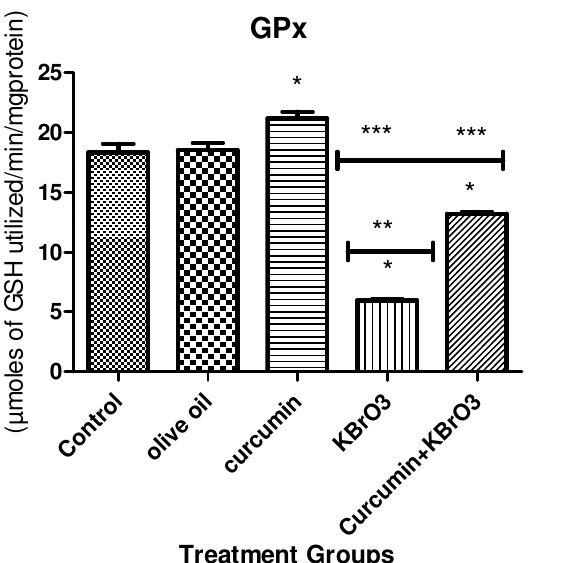
Fig. 6. Effect of curcumin on malondialdehyde (MDA) level in KBrO3-induced liver oxidative damage. Data are presented as the mean ± SD (n = 6). * values are significantly (p<0.05) different from control, **values are significantly (p<0.05) , different from curcumin+ KBrO3, ***values are significantly 3 (p<0.05) different from curcumin. For details, see legend in